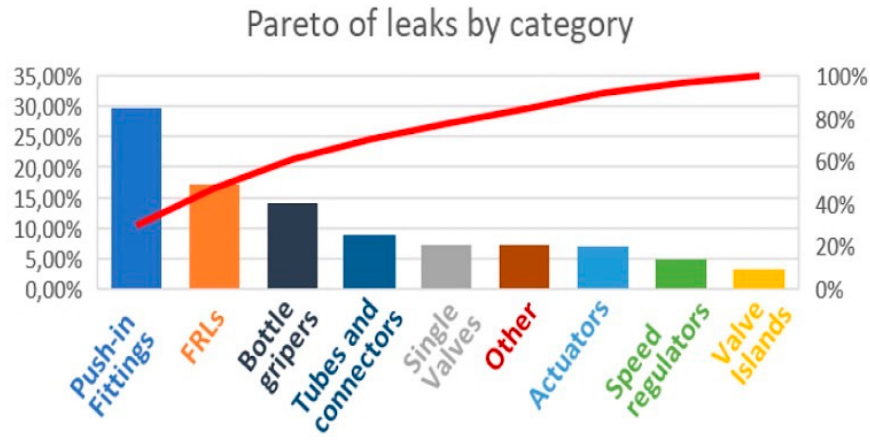
Figure 11. The Pareto chart used to highlight the fault severity in the study by R. Kosturkov et al.